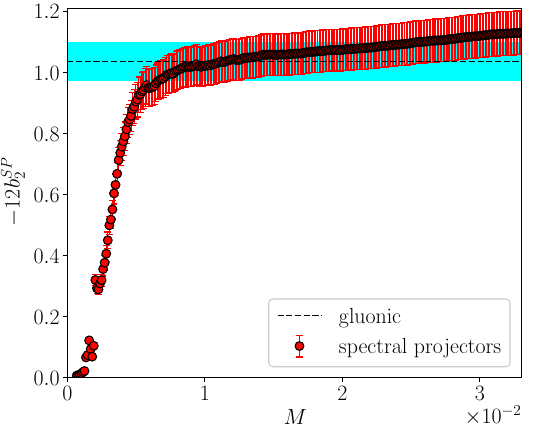
Figure 5 . Behavior of − 12 b SP compared to the gluonic definition b gluo